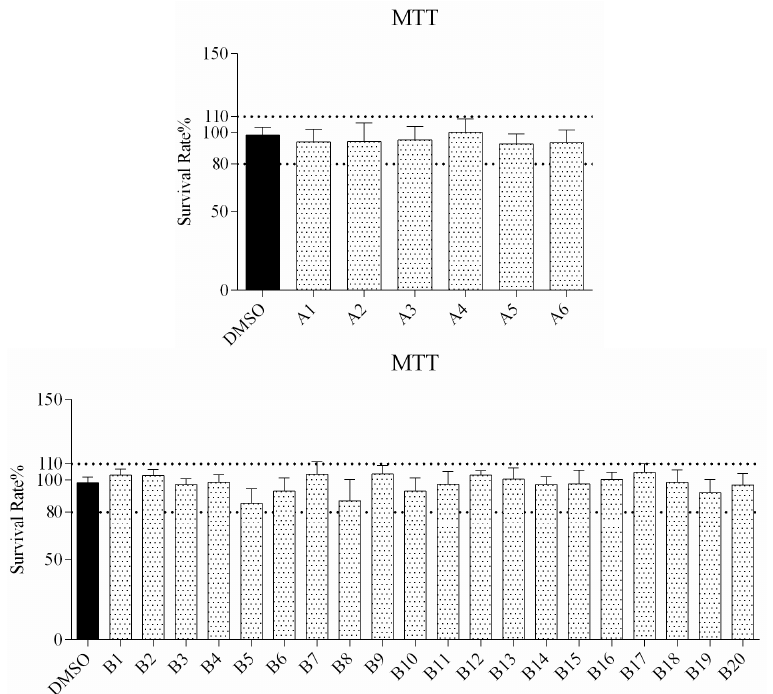
Figure 1. In vitro survival rate of RAW264.7 cells treated with compound A1 – 6 and B1 – 20 at 160 μ M.